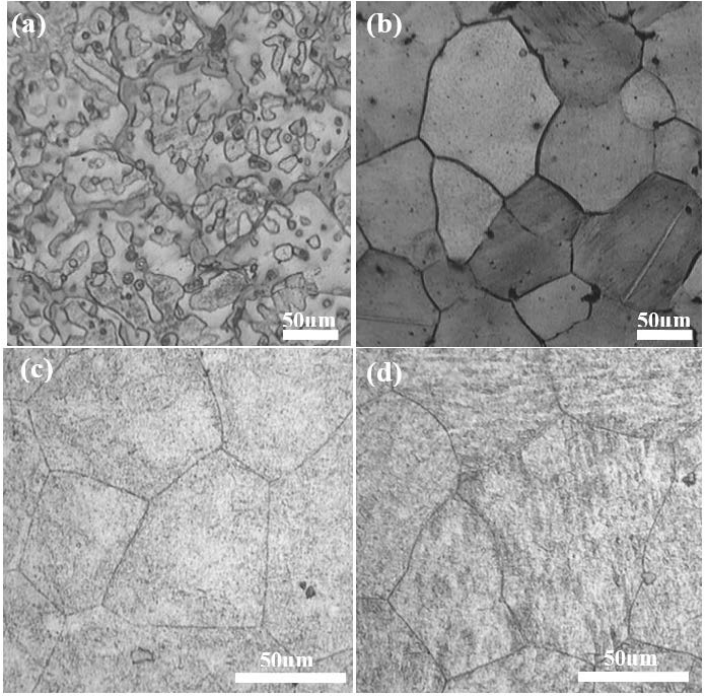
Figure 1. Optical microstructure of the TZA442 alloy: ( a ) the as-cast state; ( b ) the solution-treated state; ( c ) the 10-hour-aged state; ( d ) the 50-hour-aged state. ( c ) the 10-hour-aged state; ( d ) the 50-hour-aged